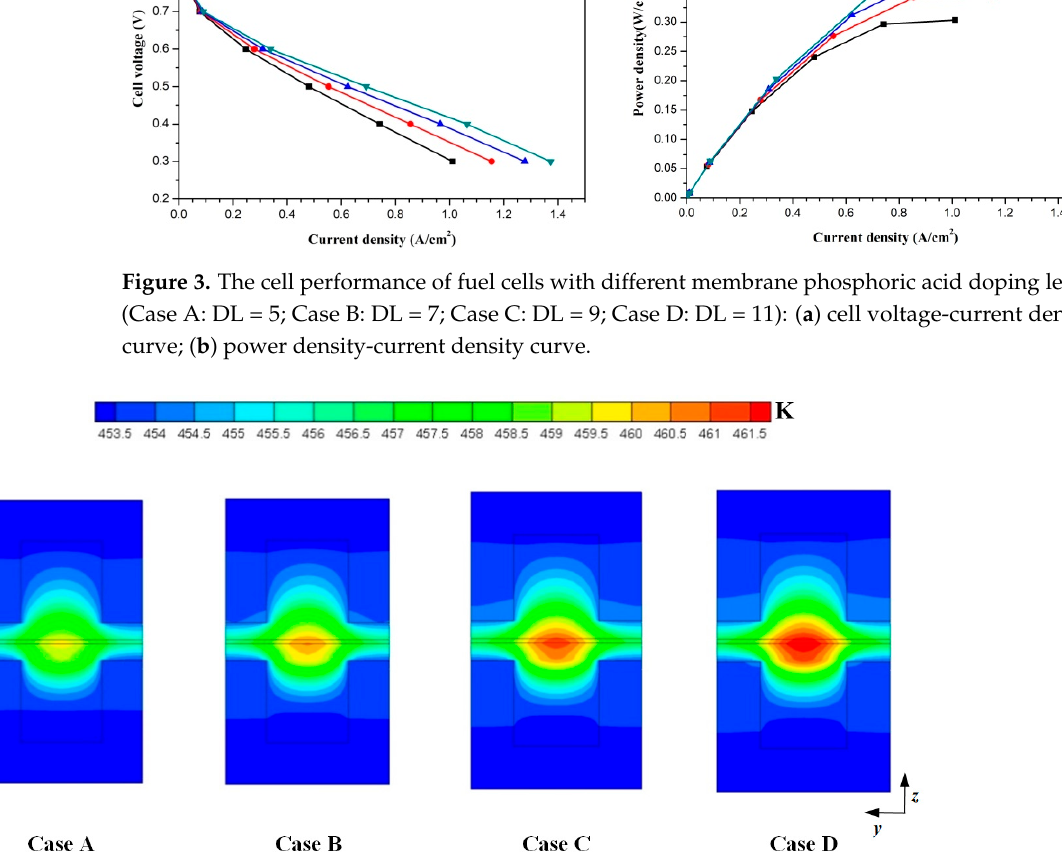
Figure 3. The cell performance of fuel cells with different membrane phosphoric acid doping levels (Case A: DL = 5; Case B: DL = 7; Case C: DL = 9; Case D: DL = 11): ( a ) cell voltage-current density curve; ( b ) power density-current density curve.